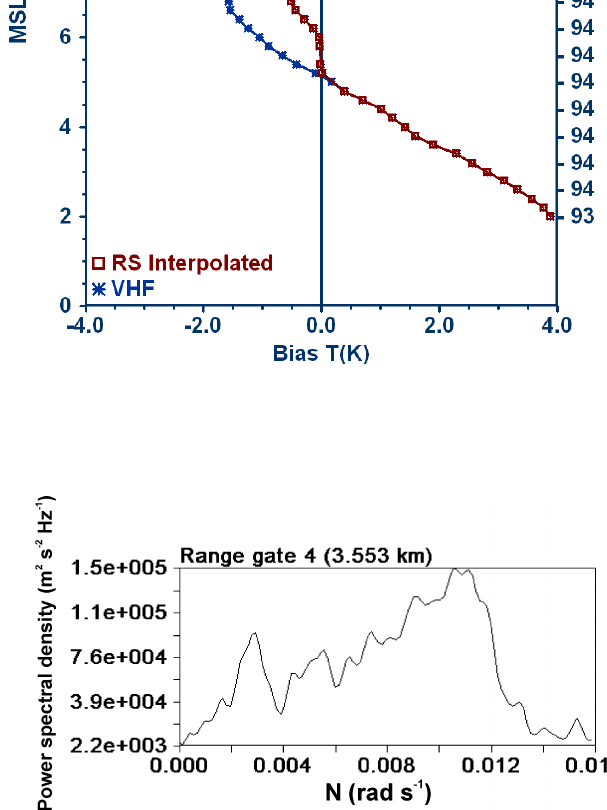
Fig. 9. Example of vertical velocity spectrum obtained with the VHF radar at 3550m on 26 March 2002 between 12:00 and 12:30UTC (34s resolution profiles with zero-padding up to 256 spectral points). The B-V frequency appears as a peak around 0.011rads − 1 corresponding to about 571s (9mn 31s)